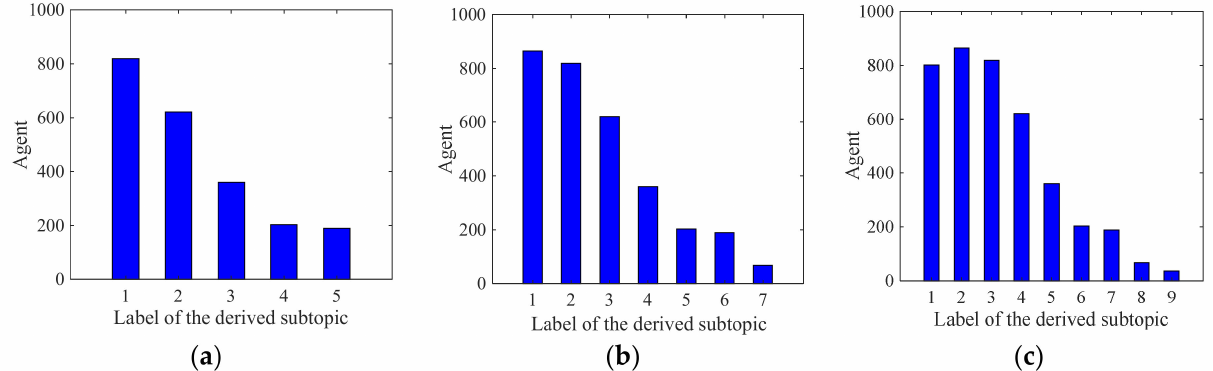
Figure 8. The number of agents participating in subtopic communication under different information alienation. ( a ) ρ = 0.75. ( b ) ρ = 0.85. ( c ) ρ =